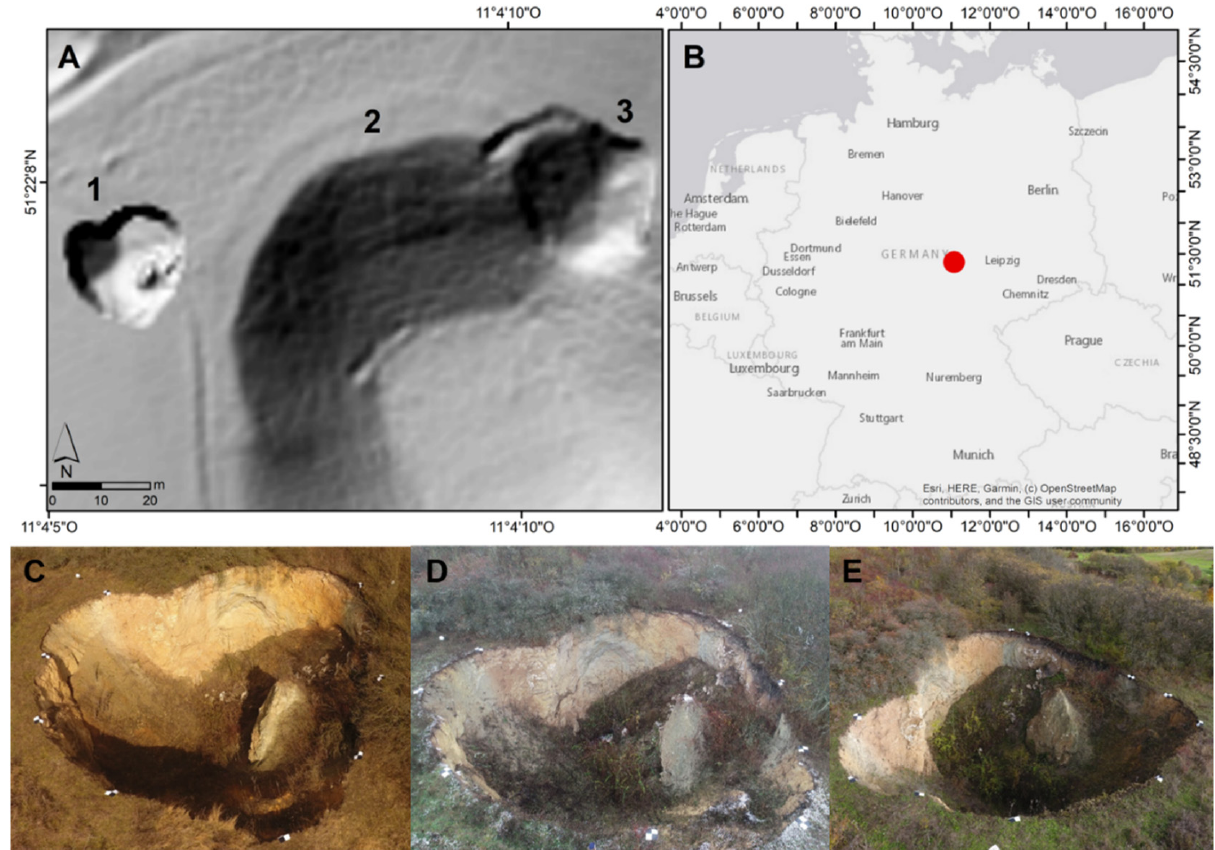
Figure 1. ( A ) (1) The studied sinkhole with the earth pillar east of the center, (2) the “Äbtissinengrube” of unknown age (myths date it back to 1600 A.D.), and (3) a sinkhole that occurred in 1953 at the edge of the “Äbtissinengrube”. ( B ) Their location in Thuringia, Germany, marked with the red square. The sinkhole and survey conditions are captured as seen from the UAV in ( C ) 2017 facing north, ( D ) 2018 facing northeast, and ( E ) 2019 facing east. Please note the earth pillar and the white gypsum rocks at the bottom in the eastern half of the sinkhole. Source: ( A ) digital terrain model provided by the Thüringer Landesamt für Bodenmanagement und Geoinformation; ( B ) Esri; ( C – E ) photos taken by Jason Goetz in 2017, 2018, and 2019 .